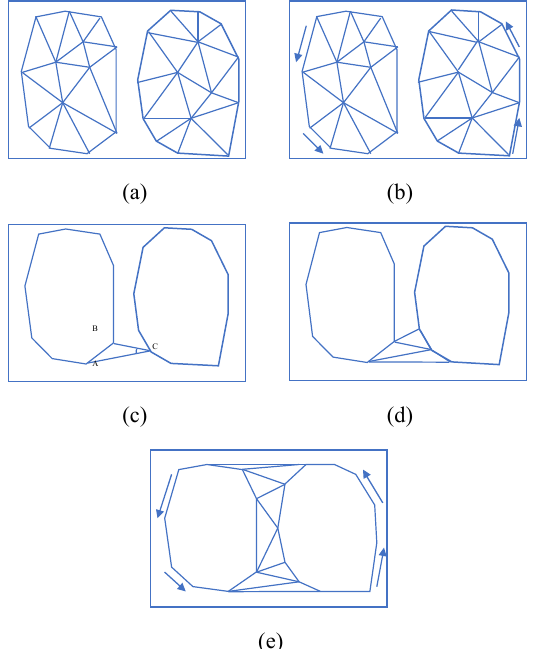
Figure 3. The general procedure of creating the new triangles on the boundary of two adjacent